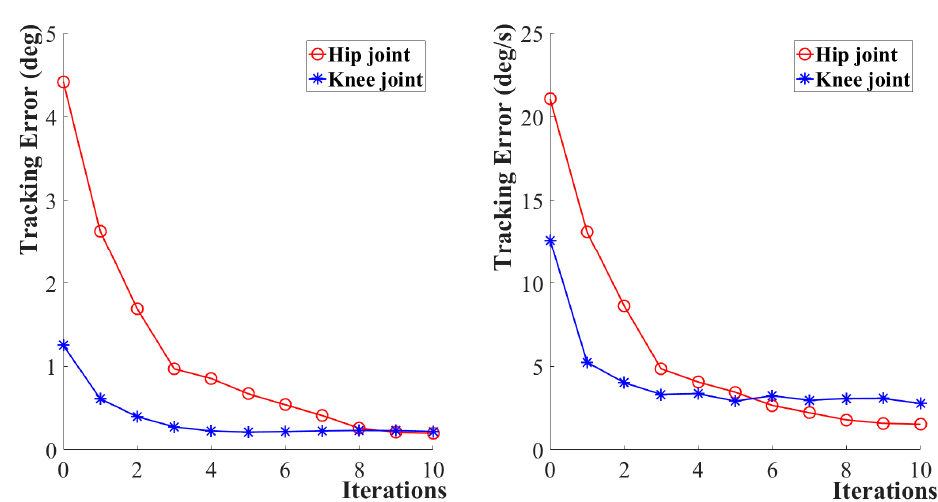
Figure 9. Tracking errors of angle ( left ) and angular velocity ( right ) over 10 iterations.